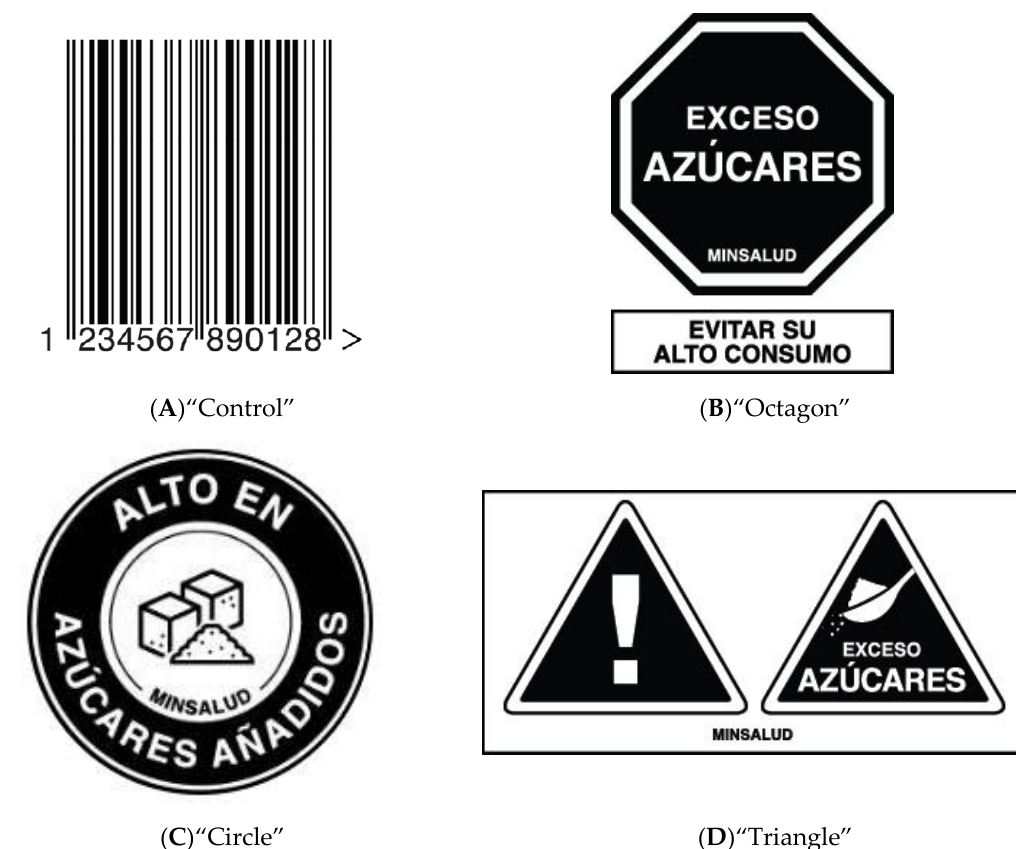
Figure 1. Control label ( A ) and warnings ( B – D ) used in experiment. Note. English translations: ( B ) Octagon text reads, “Excess sugars. Ministry of Health. Avoid high consumption.” ( C ) Circle text reads, “High in added sugars. Ministry of Health.” ( D ) Triangle text reads “Excess sugars. Ministry of Health.”.